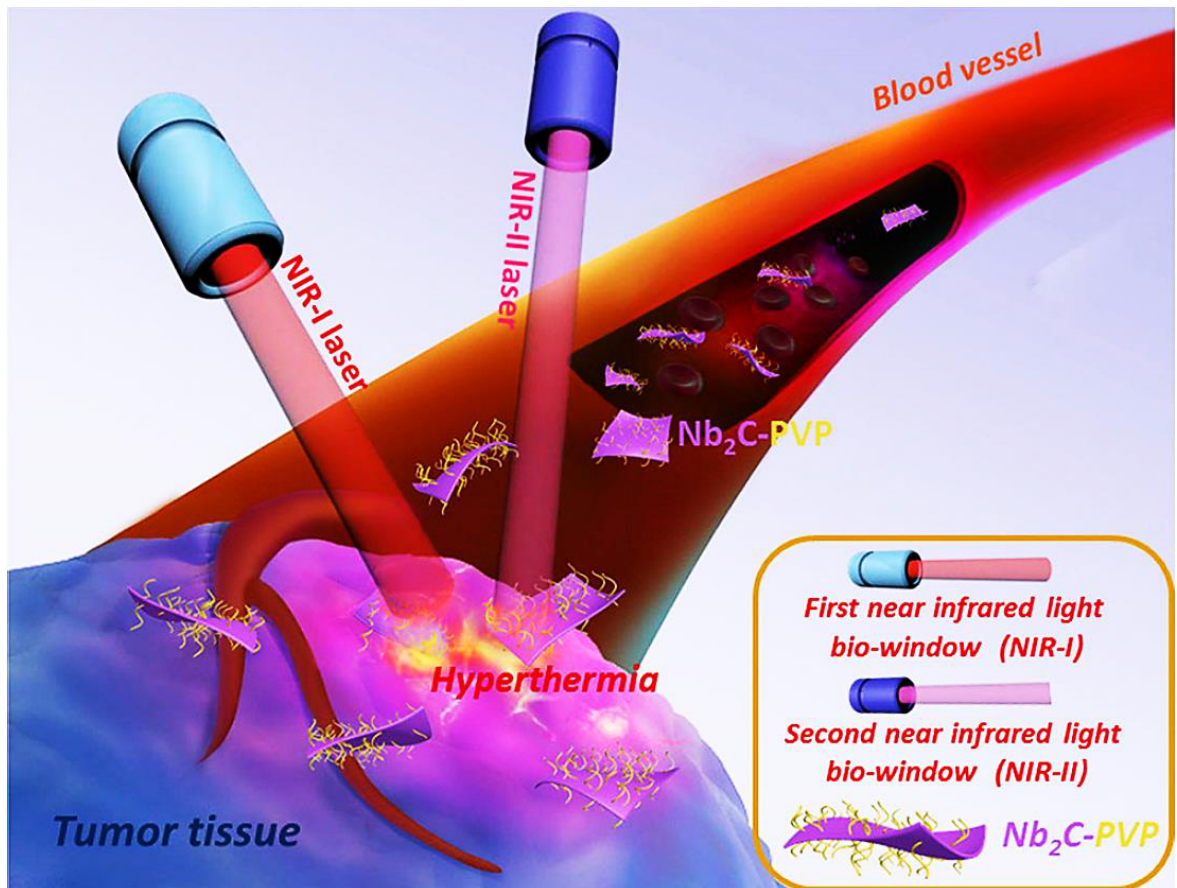
Figure 8. A sketch of Nb 2 C/PVP used for tumor ablation by In Vivo Photothermal irradiated with NIR ‐ I and NIR ‐ II (Reprinted with permission from ref. [140] Copyright 2017 American Chemical Society.